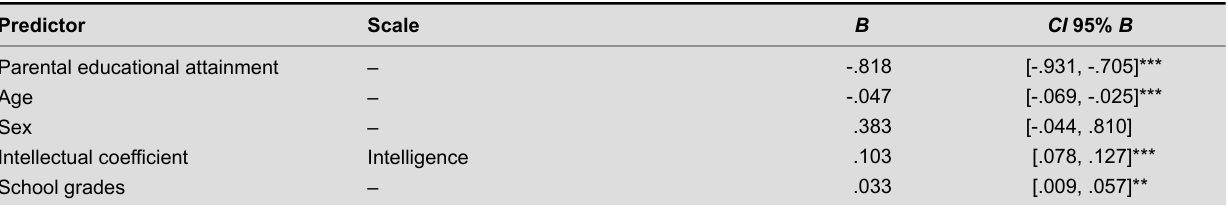
Predictors of Educational